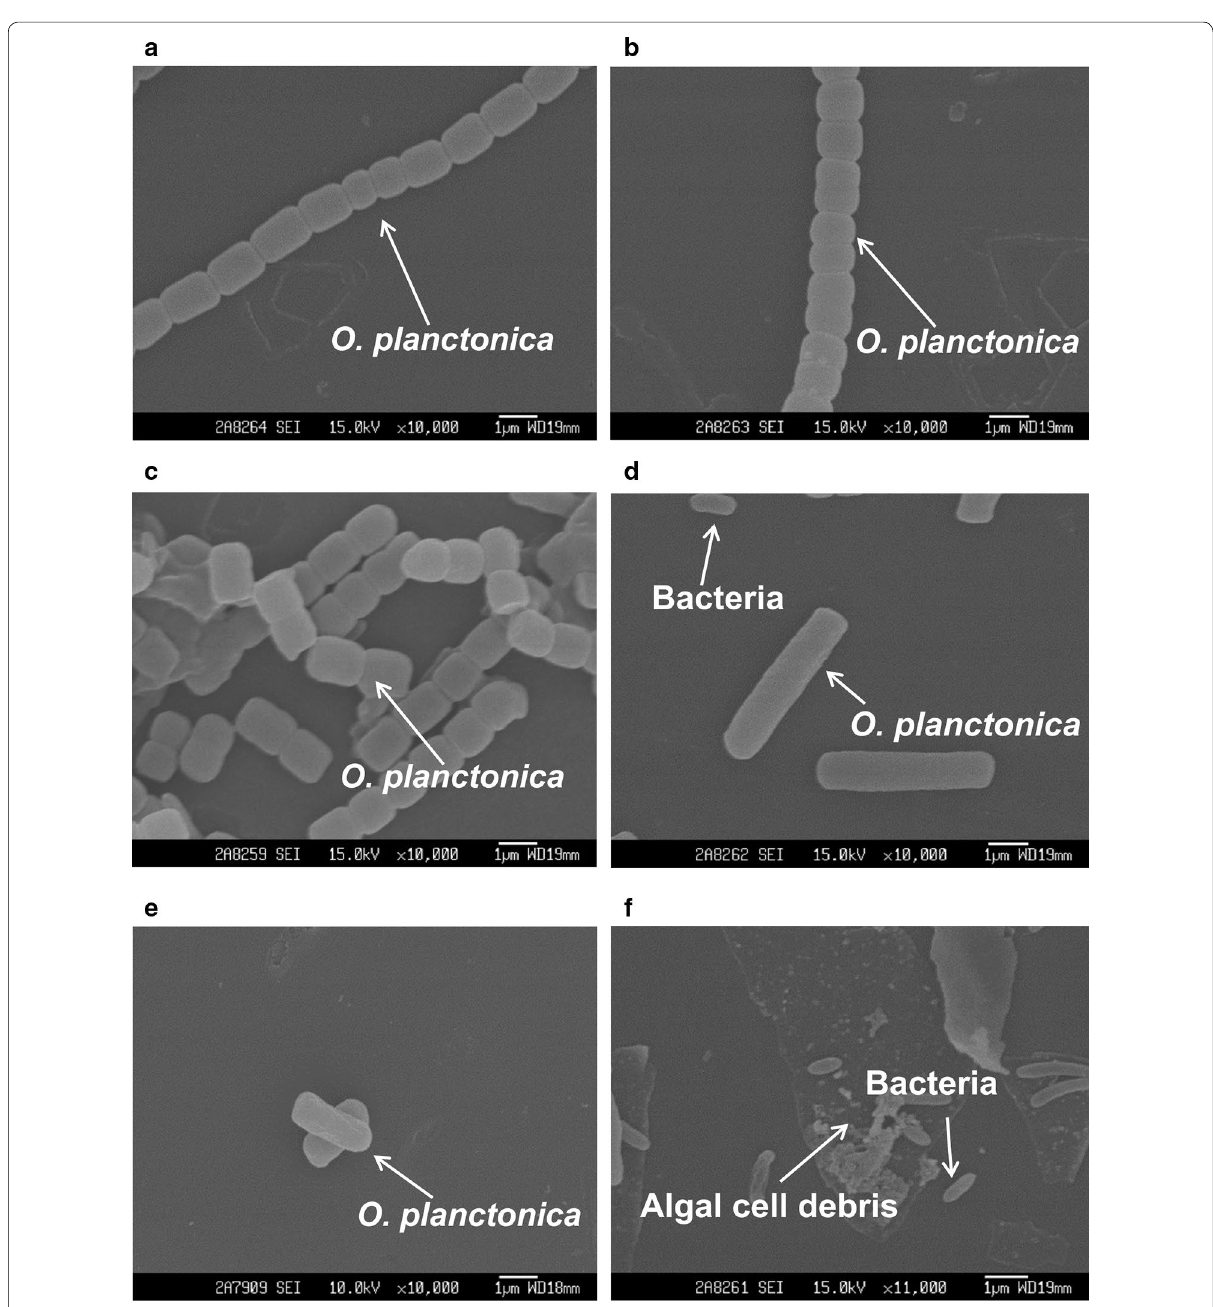
Fig. 6 Scanning electron micrographs of the effects of CZBC1 on Oscillatoria planctonica cells. a Initial stage in Op‑C. b Initial stage in Ot‑B and Op‑F. c Early stage of alginolysis in Ot‑B and Op‑F. d , e Middle stage of alginolysis in Ot‑B and Op‑F. f Late stage of alginolysis in Ot‑B and Op‑F. Op‑C: O. planctonica control group; Op‑B: O. planctonica bacterial suspension group; Op‑F: O. planctonica + +